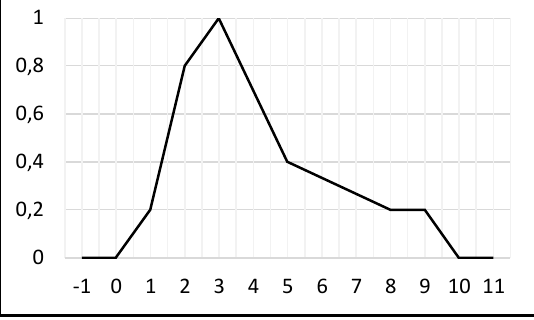
Figure 5. Custom membership